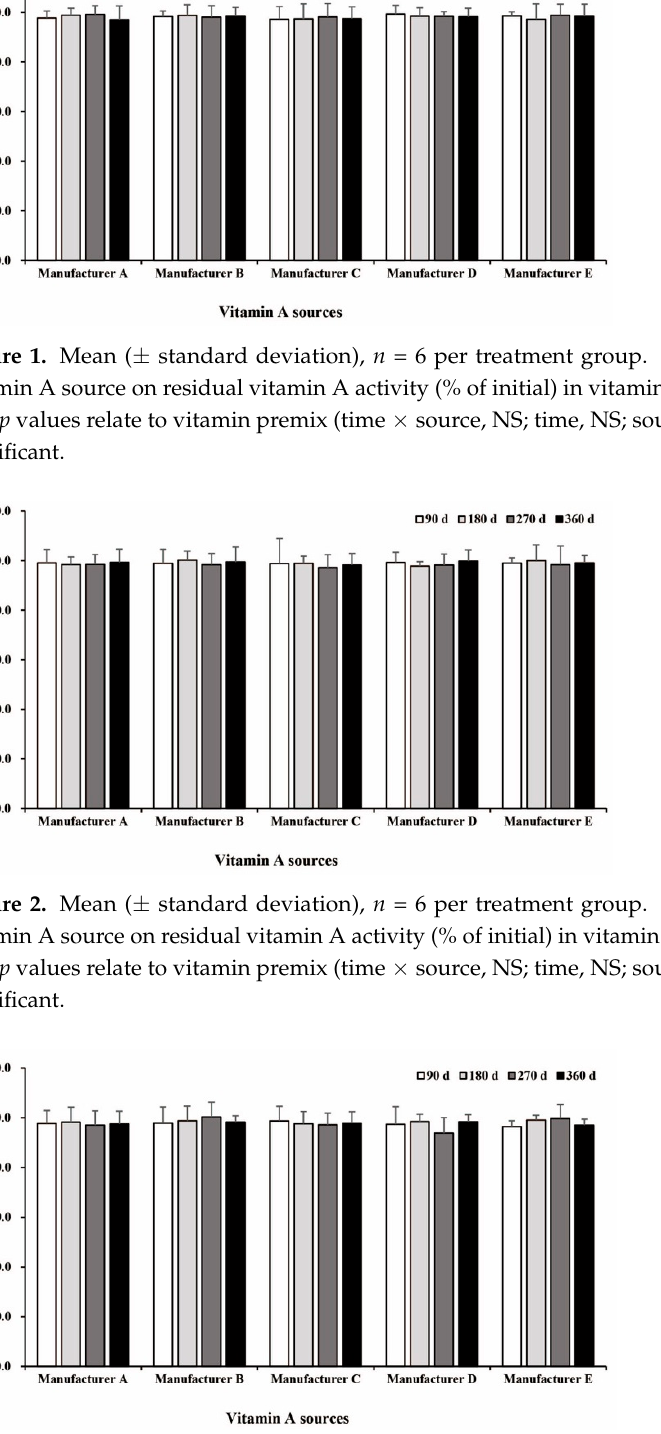
Figure 3. Mean ( ± standard deviation), n = 6 per treatment group. Effects of storage time and vitamin A source on residual vitamin A activity (% of initial) in vitamin premixes for finishing pigs. The p values relate to vitamin premix (time × source, NS; time, NS; source, NS). NS represents not significant.